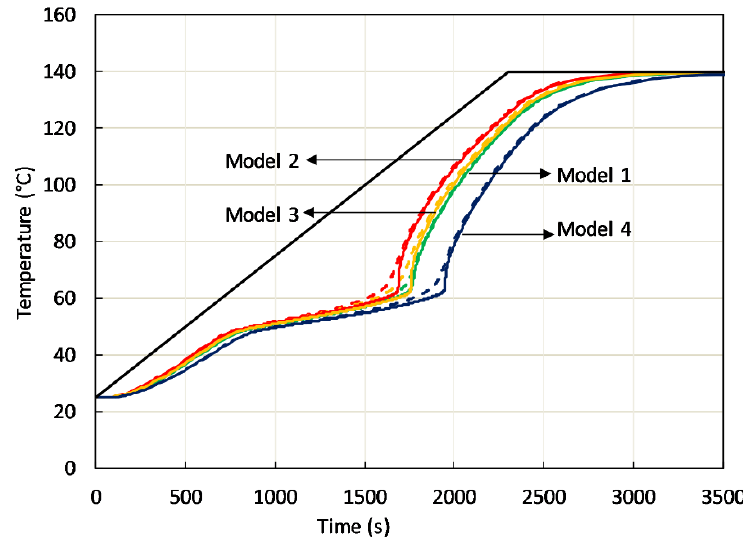
Figure 10. FE modeled temperature increase in two points laying at the same distance from the sample bottom in the active phase (solid line) and passive phase (dashed line), when sample bottom has a controlled temperature increase (black solid line). Each colour refers to a model considering a specific cell: 1: Rod-side, 2: Body centered cubic, 3: Primitive cubic, 4: Face centered cubic.